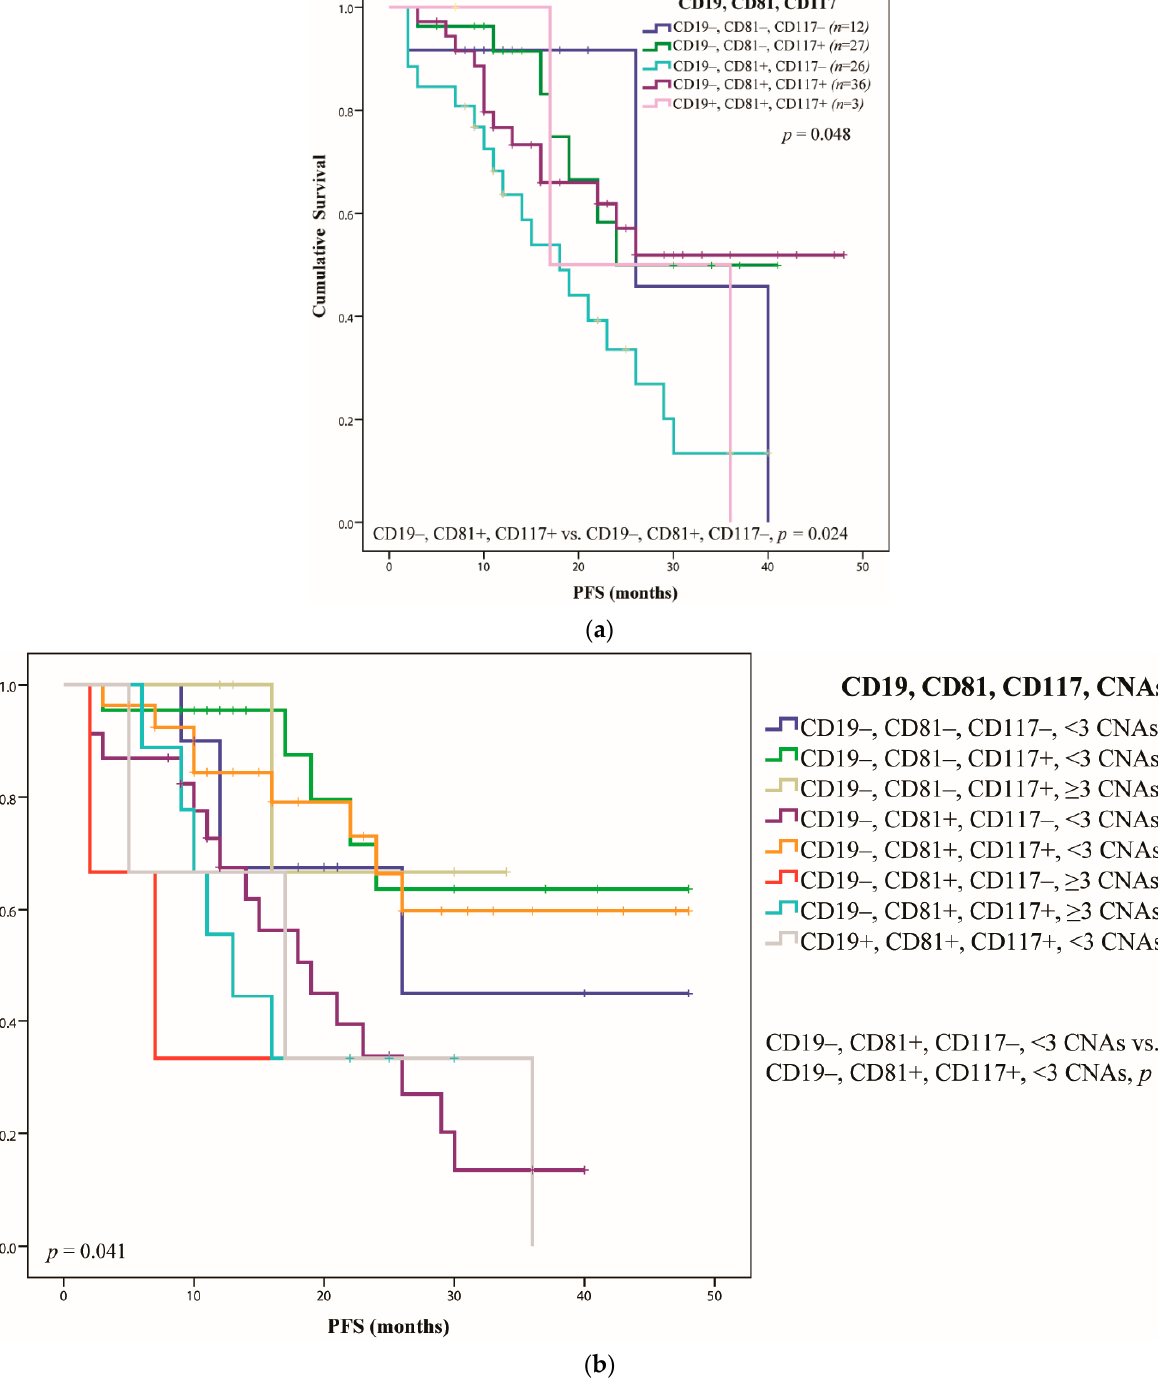
Figure 4. Correlation of PC maturation stages with CD117 ( a ) and both the expression of CD117 and adverse CNAs ( b ). The PFS was estimated by Kaplan–Meier analysis.